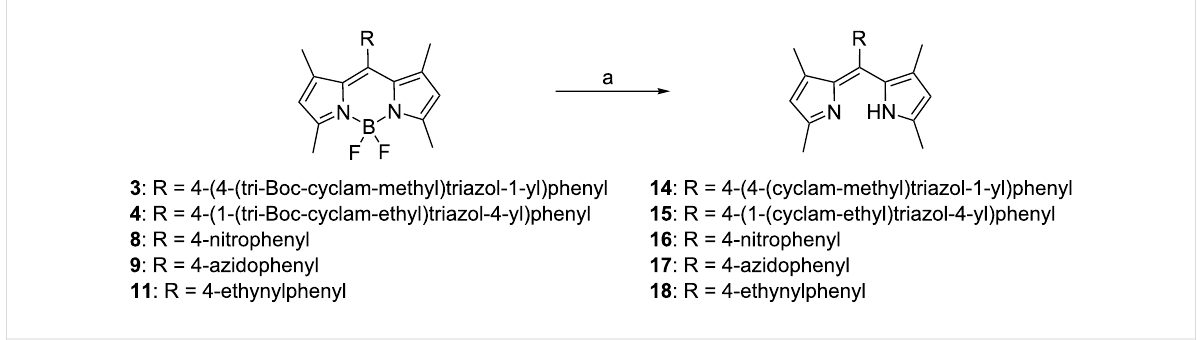
Scheme 3: Conversion of F -BODIPYs to dipyrrins using Brønsted acids. Reagents and conditions: (a) (i) TFA/DCM/H 2 O (90:5:5), rt, 6 h; or 2.8 M HCl in CH 3 OH, rt, 12–48 h; (ii) Ambersep ® 900 resin (hydroxide form), CH 3 OH, rt, 15 min (see Table 1 for yields).